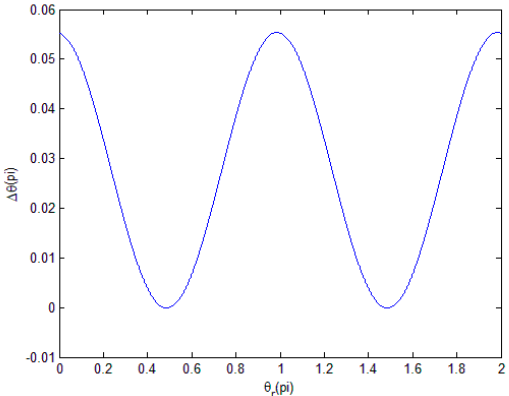
θ Δ in one period of